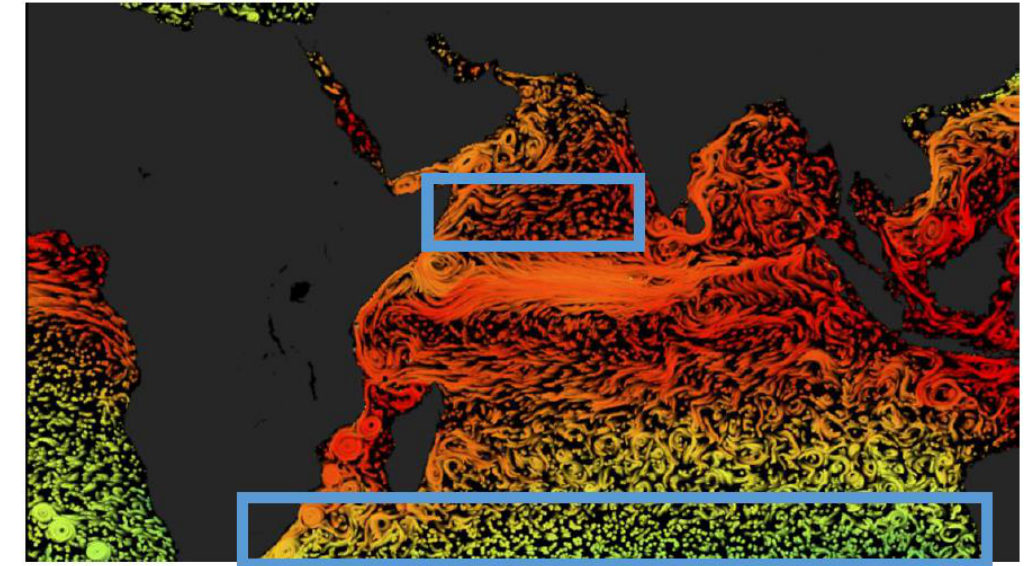
Figure2. The North Indian Ocean